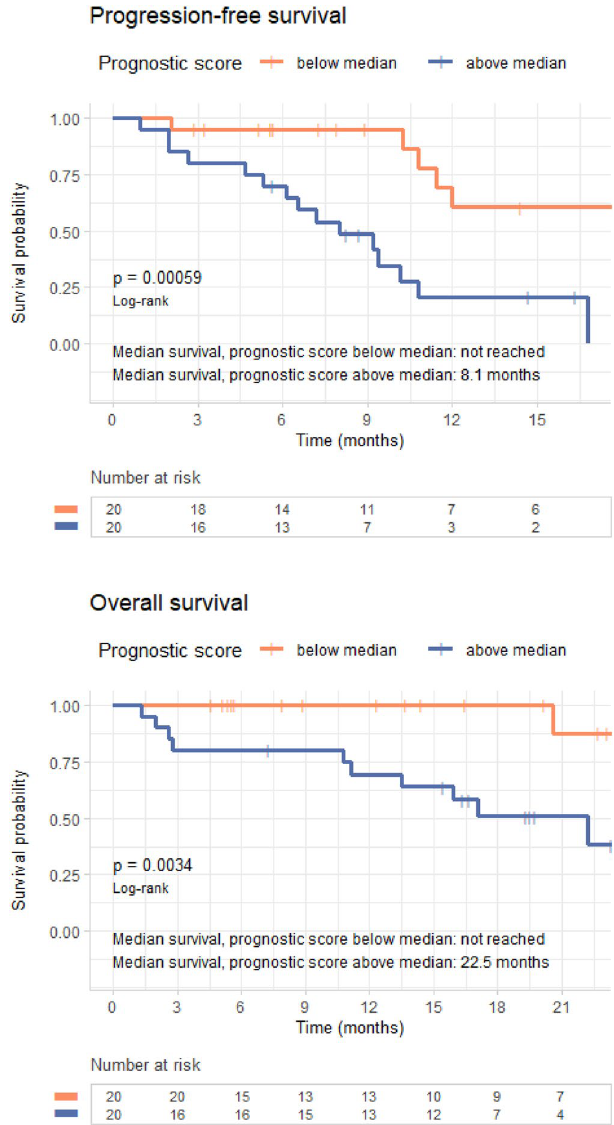
Figure 6. Survival analysis using multivariable model. Progression-free survival (top) and overall survival (bottom) analysis for the full multivariable model, including number of mutations, smoking status, Eastern Cooperative Oncology Group (ECOG) performance score, and radiomic